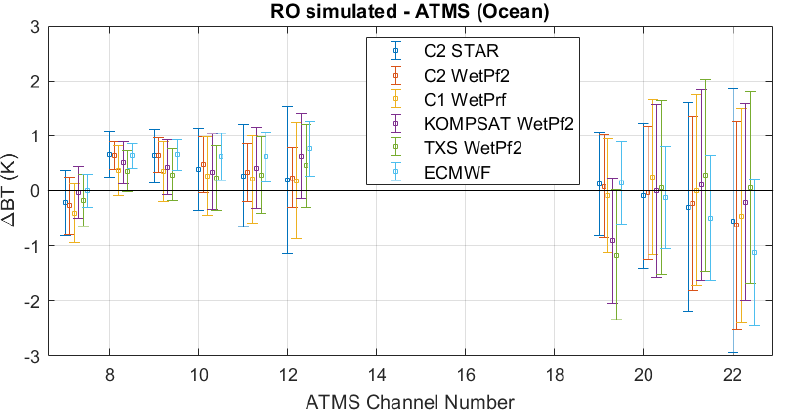
Figure 18. Inter-comparison of mean BT bias and uncertainty between CRTM-simulated BT from multi-RO or ECMWF data and ATMS BT measurements over selected ATMS channels. The texts in the figure legend correspond to data used in the CRTM simulation, such as C2 STAR: STAR COSMIC-2 WetPrf; C2 WetPf 2: UCAR COSMIC-2 WetPf 2; C1 WetPrf: UCAR COSMIC-1 WetPrf; KOMPSAT WetPrf2: UCAR KOMPSAT-5 WetPrf2; TXS WetPrf2: UCAR TerraSAR - X WetPrf2; and